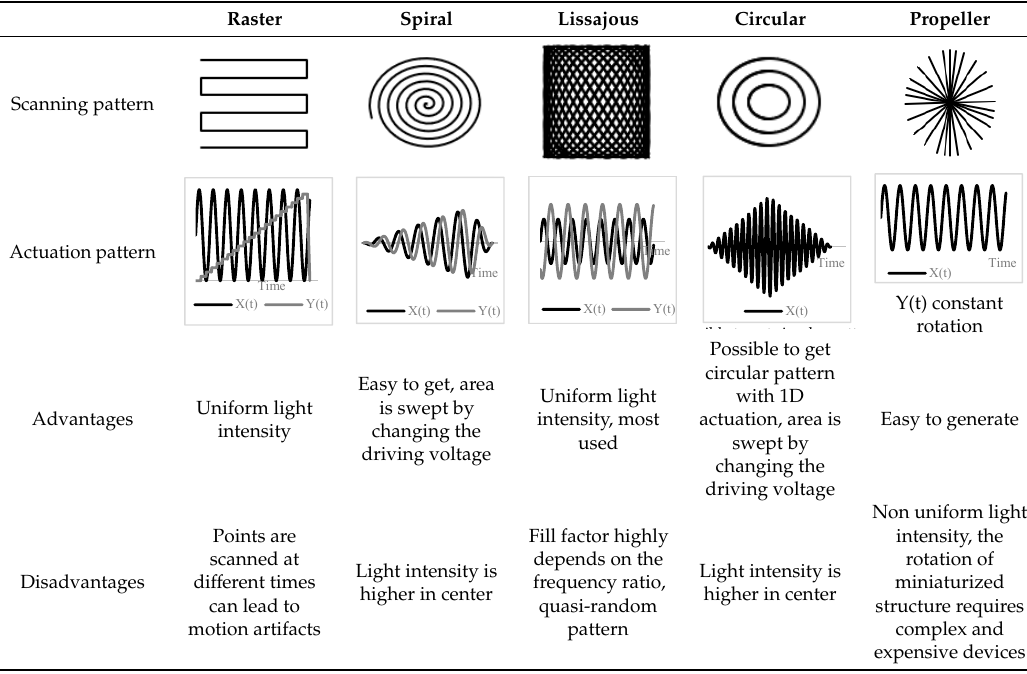
Table 5. Comparison table for di ff erent scanning patterns. Table 5. Comparison table for different scanning patterns. Table 5. Comparison table for different scanning patterns. Table 5. Comparison table for different scanning patterns. Table 5. Comparison table for different scanning patterns. Table 5. Comparison table for different scanning patterns. Table 5. Comparison table for different scanning Table 5. Comparison table for different scanning patterns. Table 5. Comparison table for different scanning patterns. Table 5. Comparison table for different scanning patterns. Table 5. Comparison table for different scanning patterns.